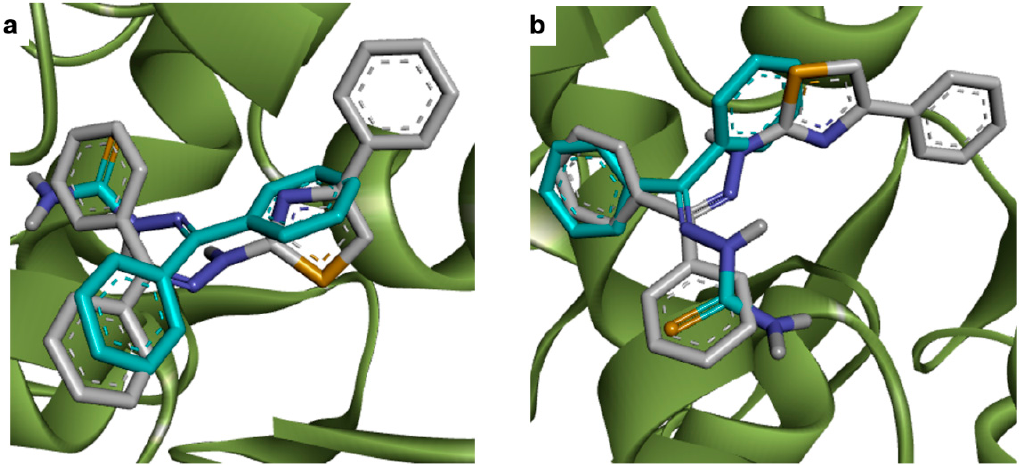
Figure 6. Comparative analysis of predicted poses of thiosemicarbazones and thiazoles into COX isoenzymes active sites (green ribbon). ( a ) Comparison between of 2a (cyan carbons, yellow sulfurs, blue nitrogens and red oxygens) and 3a (white carbons) poses into COX-1 (PDB ID: 2OYU) active site; ( b ) Comparison between of 2a (cyan carbons) and 3a (white carbons) poses into COX-2 active site (PDB ID: 3NT1).